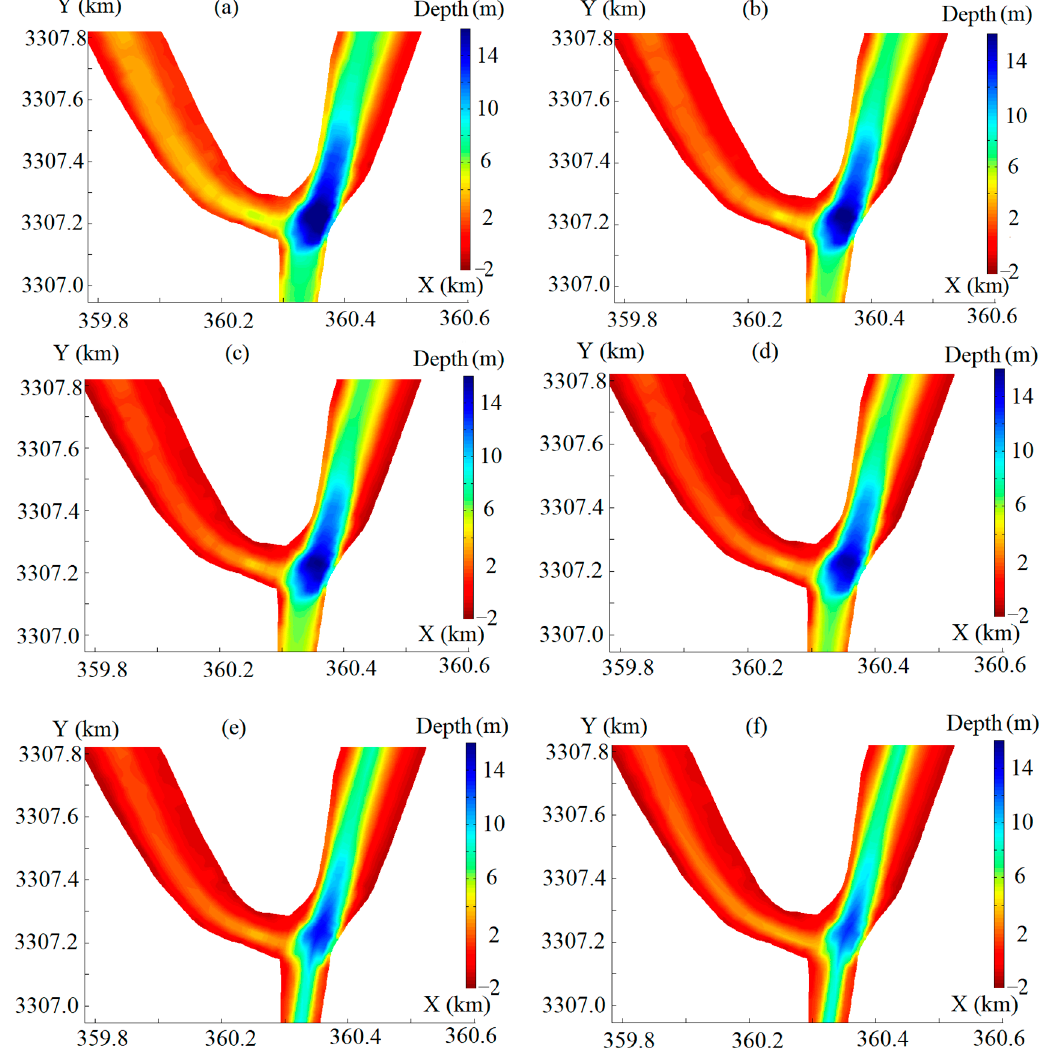
Figure 18. River-bed morphology changes in the confluence: ( a ) T = 0; ( b ) T = 30 days; ( c ) T = 60 days;